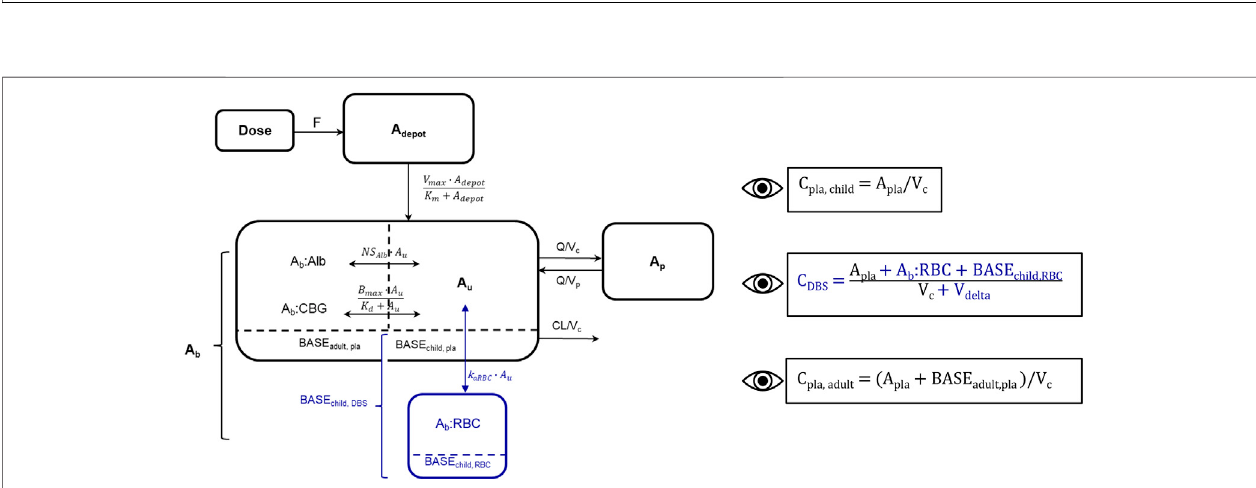
FIGURE2| SchematicrepresentationofdevelopedcortisolPKmodelincludingadultplasmadataandpediatricplasmaanddriedbloodspot(DBS)data,blue:new DBS-relatedcompartments/parameters/data.Bioavailability(F),amountindepotcompartment(A depot ),maximumabsorptionrate(V max ),amountindepotcompartment resulting in half of V max (K m ), amount bound (A b ), amount bound to albumin (A b :Alb), amount associated to red blood cells (A b :RBC), unbound amount (A u ), amount bound to corticosteroid-binding globulin (A b :CBG), linear non-speci fi c parameter for albumin binding (NS Alb ) and association to red blood cells (k aRBC ), maximum binding capacity (B max ), equilibrium dissociation constant (K d ), intercompartmental clearance (Q), peripheral volume of distribution (V p ), cortisol plama baseline of dexamethasone suppressed healthy adults (BASE adult, pla ), cortisol plasma baseline of children (BASE child, pla ), cortisol DBS baseline of children (BASE child, DBS ), cortisol associatedtoredbloodcellsatbaselineinchildren (BASE child,RBC ).Thedashedlinedividesthecentral compartmentintotheA b andA u subcompartments, respectively. Eyesnexttoequationsindicateobservedconcentrations:Pediatricplasma(C pla,child )andDBS(C DBS )concentrations,adultplasmaconcentrations(C pla,adult ),volumeof red blood cell compartment (V delta